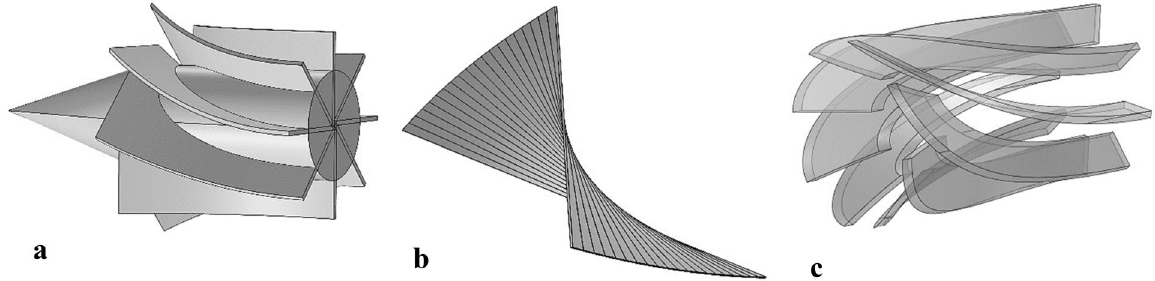
Figure 2. The structure of different studied swirler ( a ) axial swirler with a cone core, ( b ) helical swirler, ( c ) wall- mounted wall-mounted swirler with the drainage port because the central droplets are far away from the separator wall. Therefore, this distance is required to provide enough time for reaching the droplets toward the separator wall. In